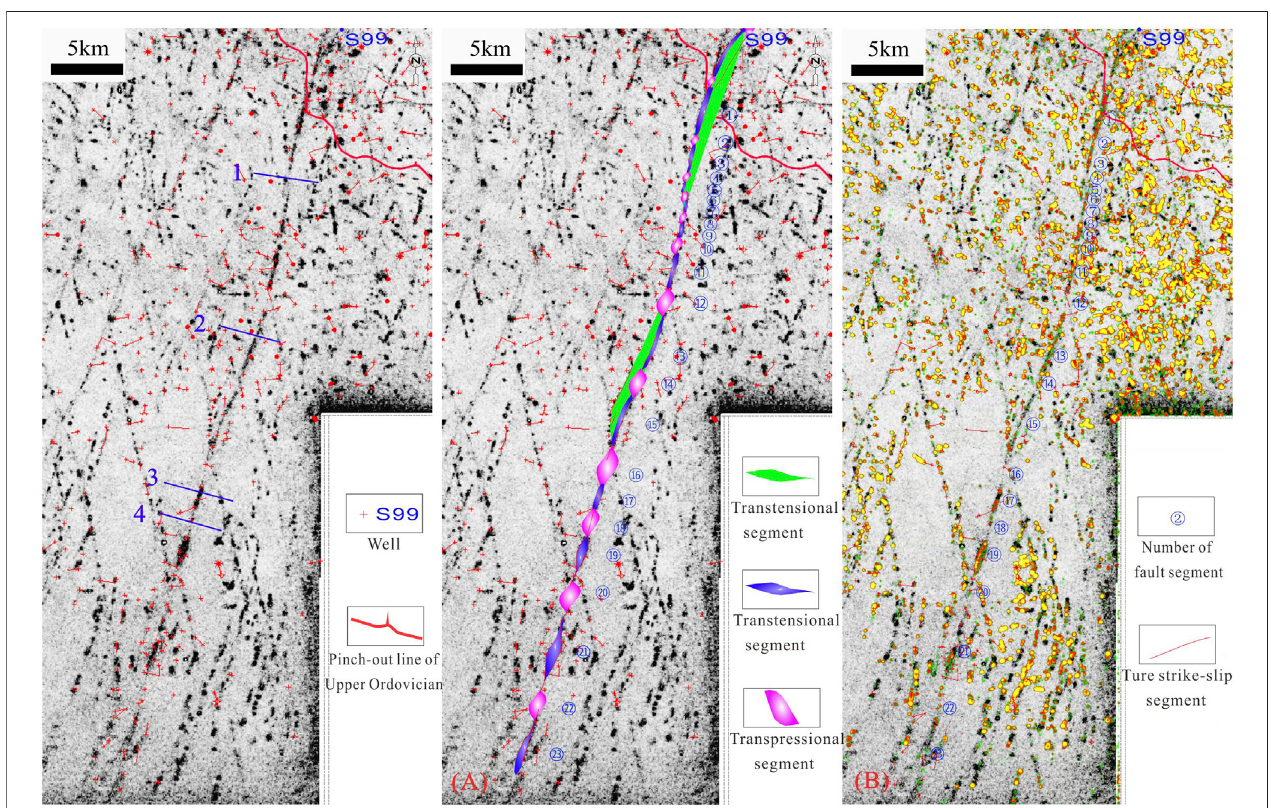
FIGURE 4 | (A) Segmented results of TP12CX fault (B) Amplitude rate of T74 and coherence of T76